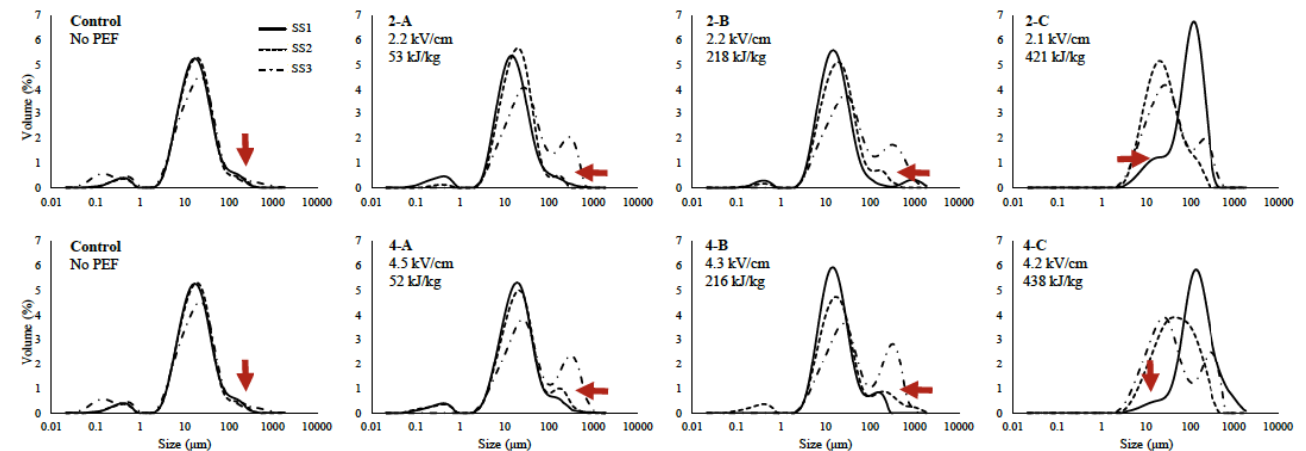
Figure 3. Volume distribution of particles in selected representative flour segments (Solid Segment 1/SS1, Solid Segment 2/SS2, and Solid Segment 3/SS3) obtained from PEF-treated oat flour. Red arrows on the figure points out to the shoulders (indicate particle aggregation) observed on the distribution curve of the samples.